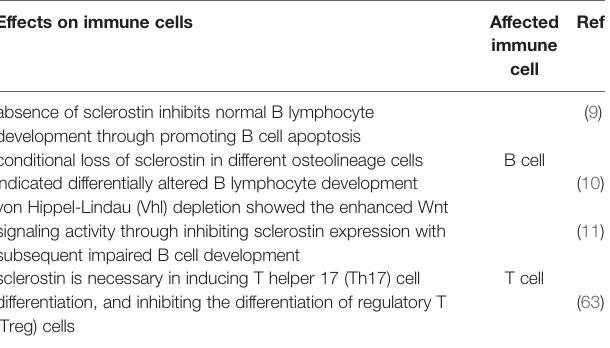
TABLE 2 | Effects of sclerostin on immune